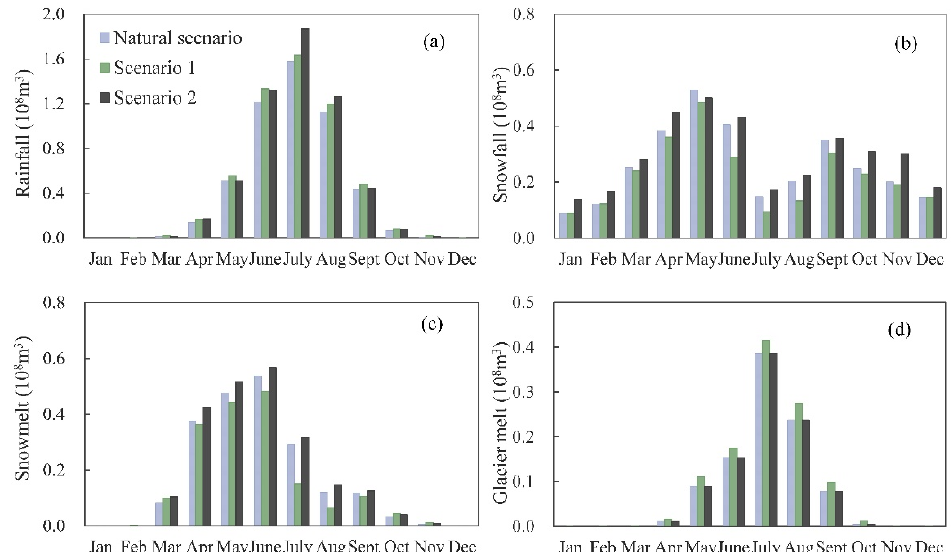
Figure 5. Seasonal distributions of: ( a ) rainfall; ( b ) snowfall; ( c ) snowmelt; and ( d ) glacier melt, under three simulated scenarios for the Jinghe River Basin.